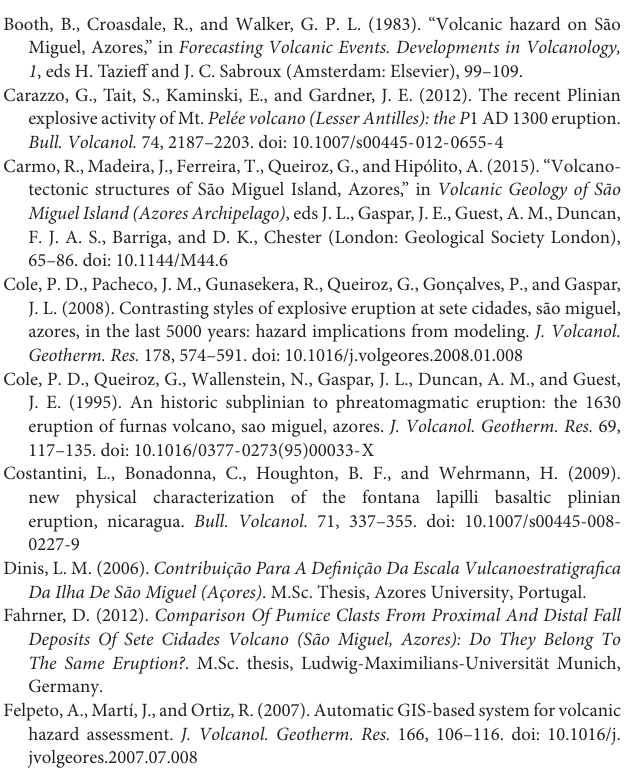
FIGURE S1 | Stratigraphic sections of nine outcrops along the north coast of São Miguel Island containing a pumice lapilli bed with black inclusions, highlighted in yellow (Ponte, 2013). In this study, this pumice fall bed is correlated to the Upper Member of the SBF. TABLE S1 | Overview of values of trace elements for the 7 different sample